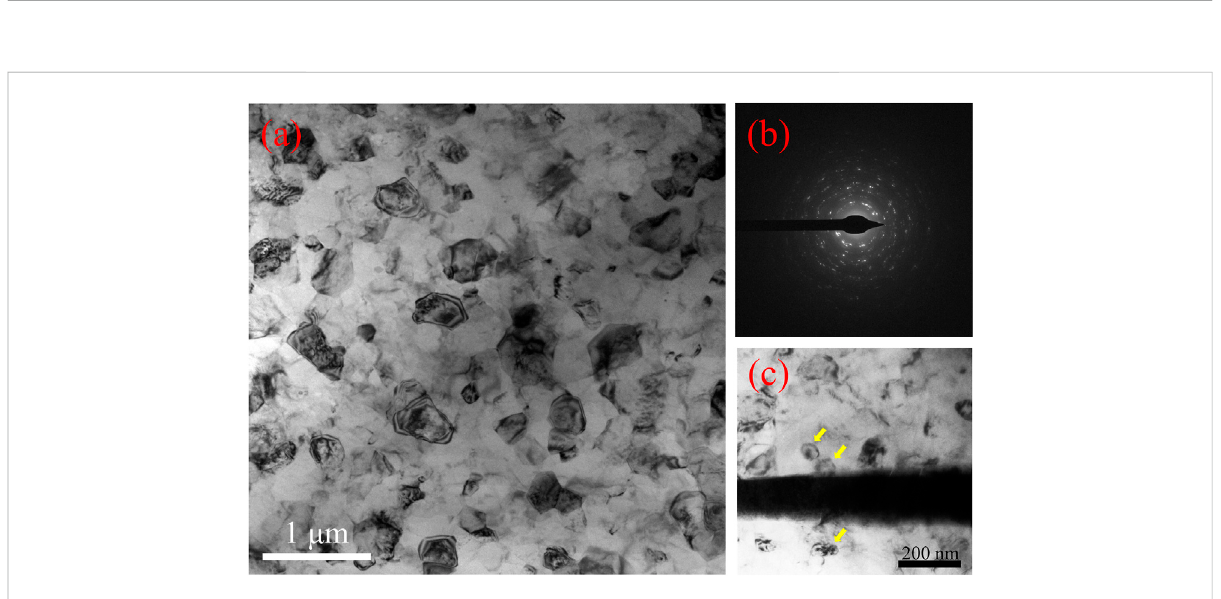
FIGURE 3 TEM characterization of the LT146-LSR. (A) Bright- fi eld TEM image of LT146-LSR alloy, (B) corresponding selected-area diffraction pattern, (C) bright- fi eld TEM image near the broken second